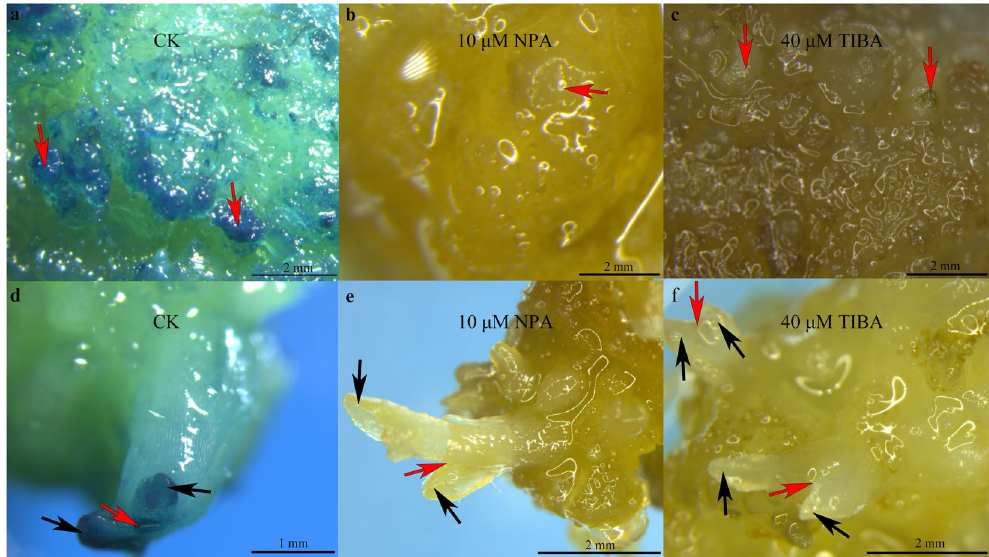
Figure 3. TIBA and NPA disrupted the spatial expression of KdSOC1 gene promoter driving GUS reporter gene during tobacco somatic embryogenesis. ( a ) Normal callus induction medium (CK) without TIBA or NPA. ( b ) Callus induction medium with 10 μ M NPA. ( c ) Callus induction medium with 40 μ M TIBA. ( d ) Normal shoot induction medium (CK) without TIBA or NPA. ( e ) Shoot induction medium with 10 μ M NPA. (f) Callus induction medium with 40 μ M TIBA.